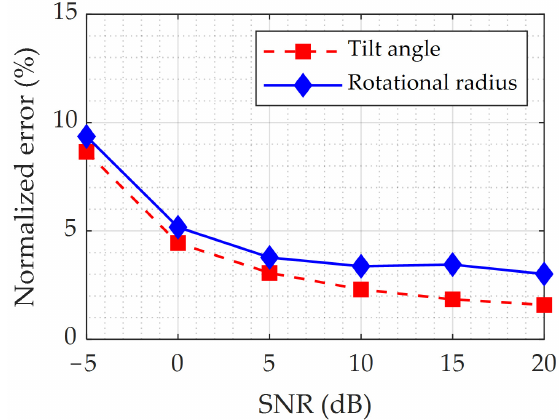
Figure 12. The variation of the real rotational radius and tilt angle estimation errors with the SNR.